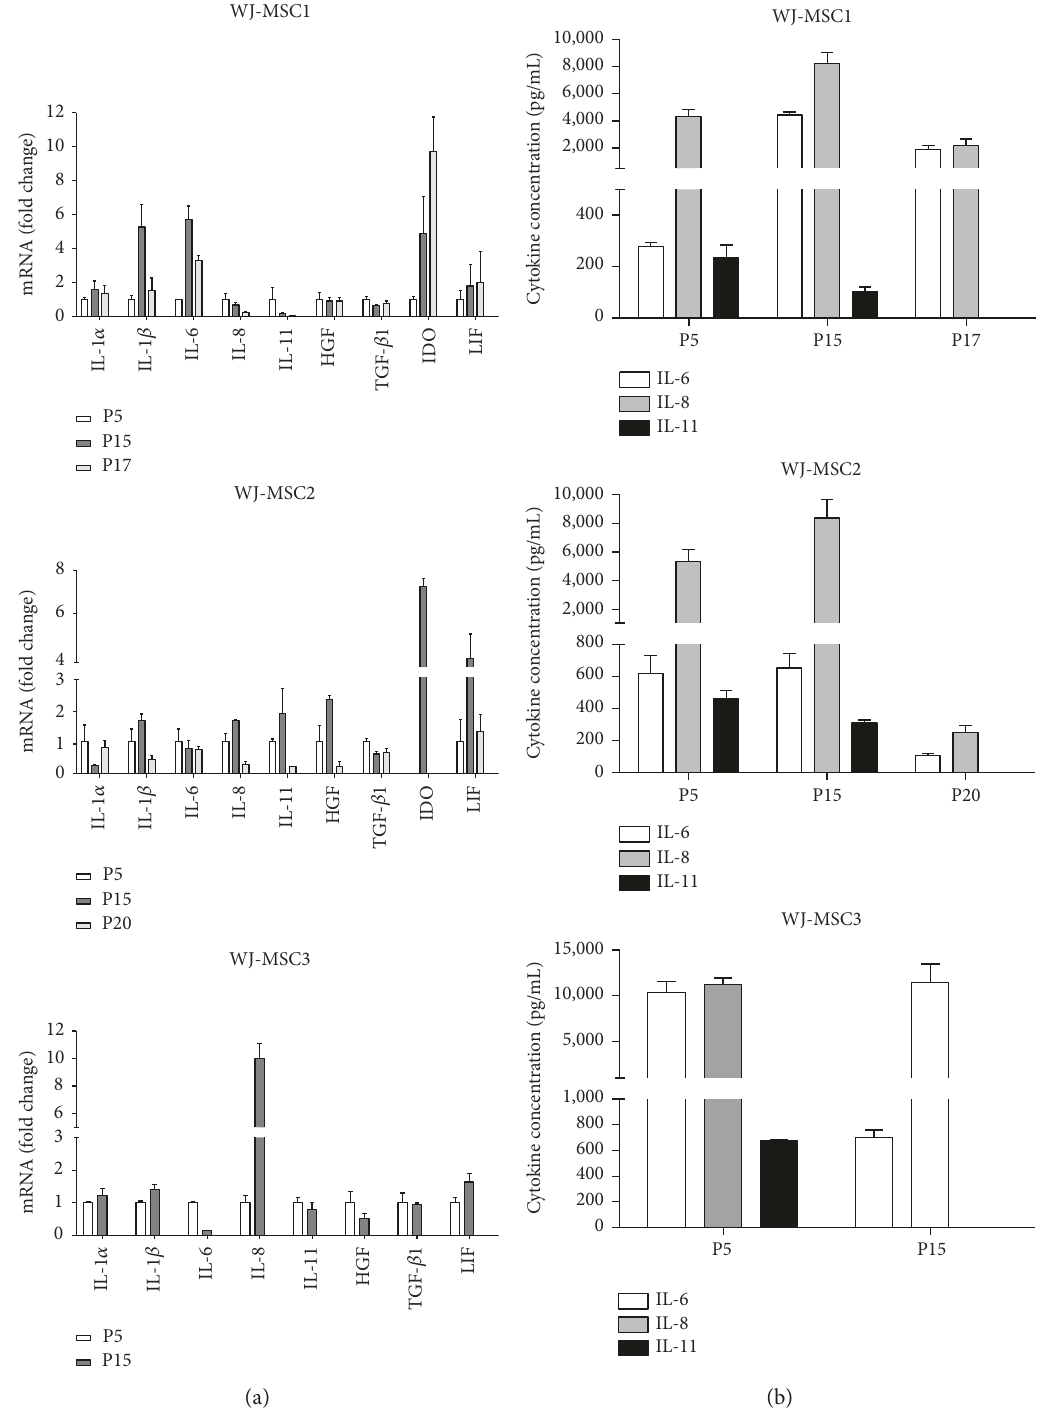
Figure 1: WJ-MSC gene expression of immunomodulatory molecules. Cells were seeded at a density of 4000 cells per cm 2 , and samples were collected at 3 di ff erent passages. After reaching 80% of con fl uence, cells were lysed, total RNA extracted, and real-time PCR performed. IL-1 α , IL-1 β , IL-6, IL-8, IL-10, IL-11, HGF, TGF- β 1, IDO, and LIF gene expression and protein secretion from WJ-MSC1, WJ-MSC2, and WJ- MSC3. (a) Gene expression and (b) protein secretion. Gene expression was normalized by housekeeping gene GAPDH and expressed as fold change compared to the control — passage 5. Experiments were performed in triplicate. Results are represented as mean ± SD ( n = 3